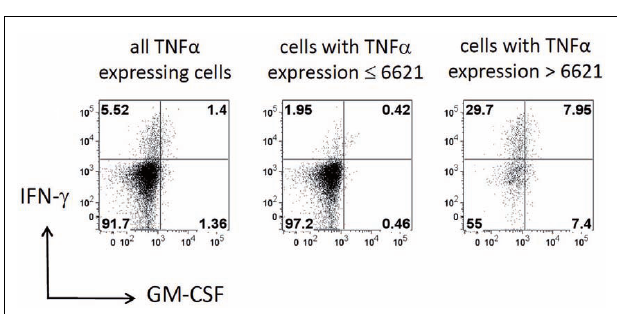
FIGURE 7 | Cells with highTNF- α expression are enriched for IFN- γ expressing cells. Dot plots show the expression of IFN- γ vs. GM-CSF in the same data set for all cells with expression ofTNF- α (left), for cells with expression ofTNF- α below the split value 6621 given by the decision tree shown in Figure 6 (middle) and for cells with highTNF- α expression (right). Horizontal and vertical lines represent the experimentally determined cut-off values that define the expression for these cytokines as estimated by controls.The cells in the lower left quadrant produce neither IFN- γ nor GM-CSF and the cells in the upper right quadrant produce both. Numbers in quadrants give the percentage of the cells in the respective quadrant.